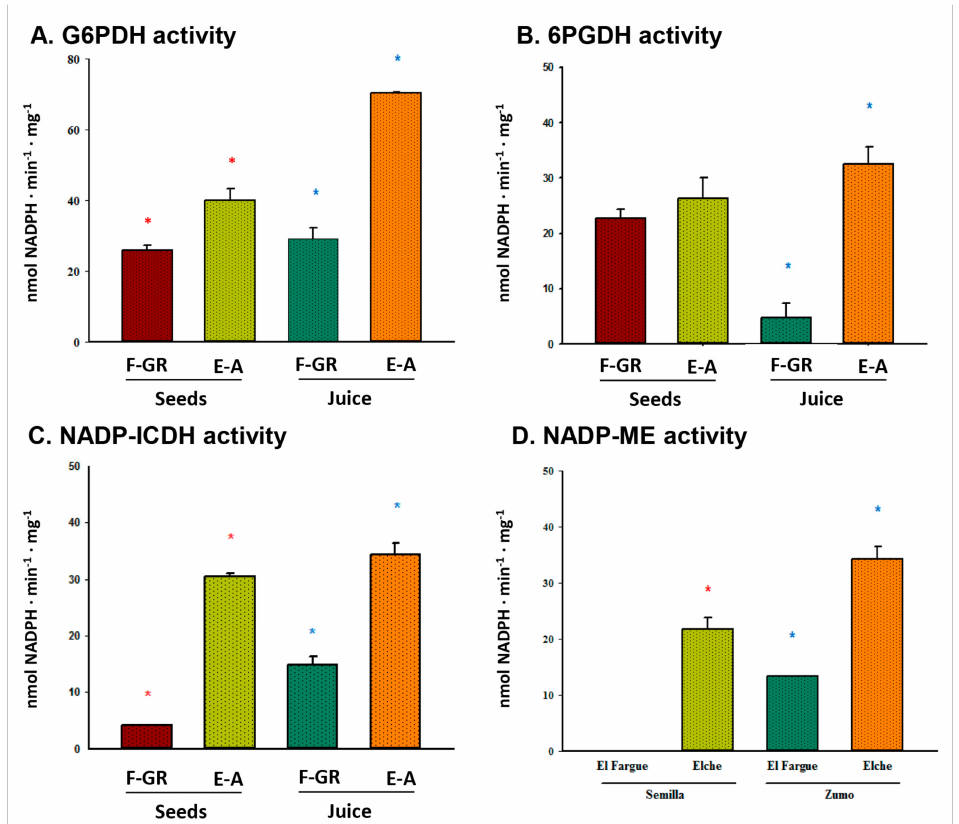
Figure 4. Activity of NADP-generating dehydrogenases in seeds and juice from two Spanish pomegranate populations. Pomegranate fruits from El Fargue, Granada (F-GR) and Elche, Alicante (E-A) were analyzed. ( B ) 6-phosphlogluconate dehydrogenase (6PGDH); ( C ) NADP-dependent isocitrate dehydrogenase (NADP-ICDH); ( D ) NADP-dependent malic enzyme (NADP-ME). Colored asterisks depict significant di ff erences ( p < 0.05) between either seed (red) or juice (blue) samples according to the Student’s t